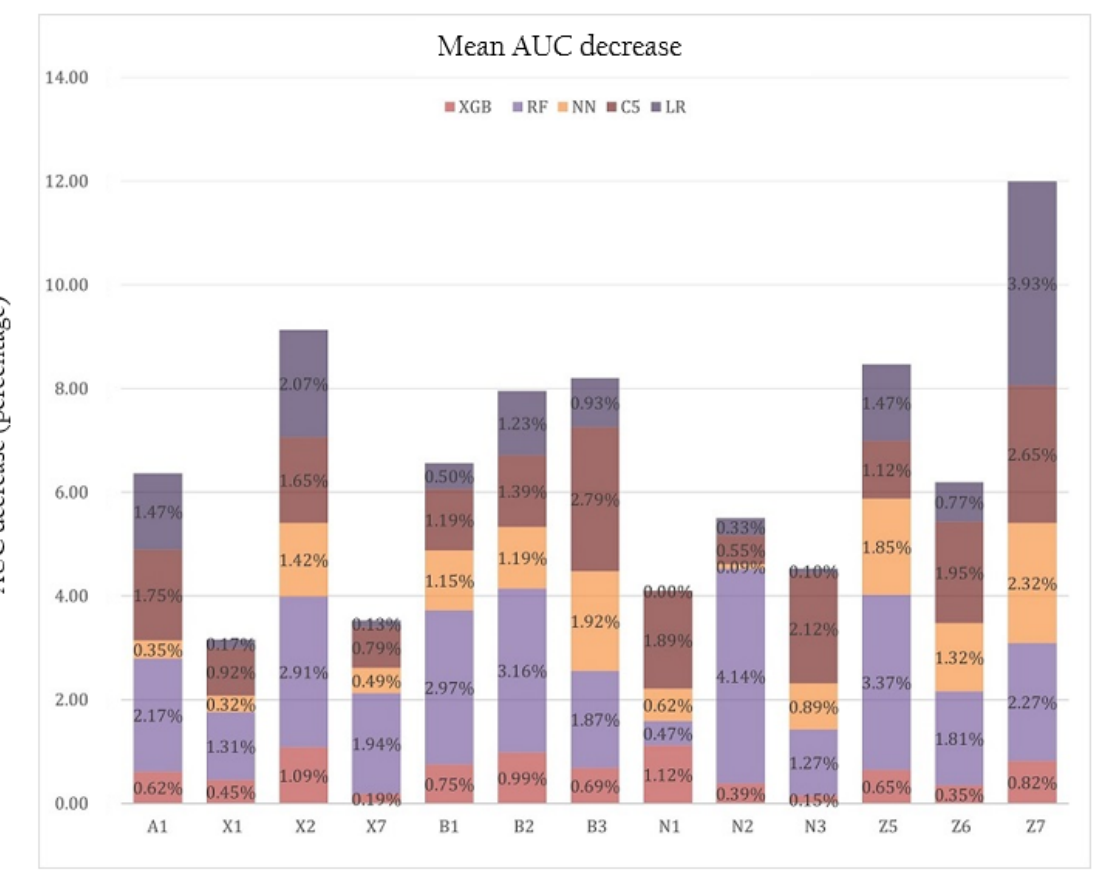
Figure 2. The impact of different linguistic features on the machine learning algorithms. AUC: area under the receiver operating characteristic